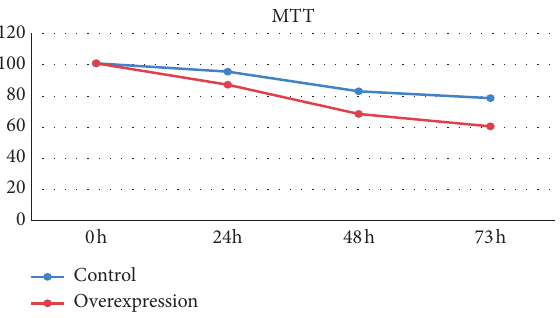
Figure 10: Cell proliferation of PTC-UC3 after ADD3-AS1 overexpression was detected by MTT assay.